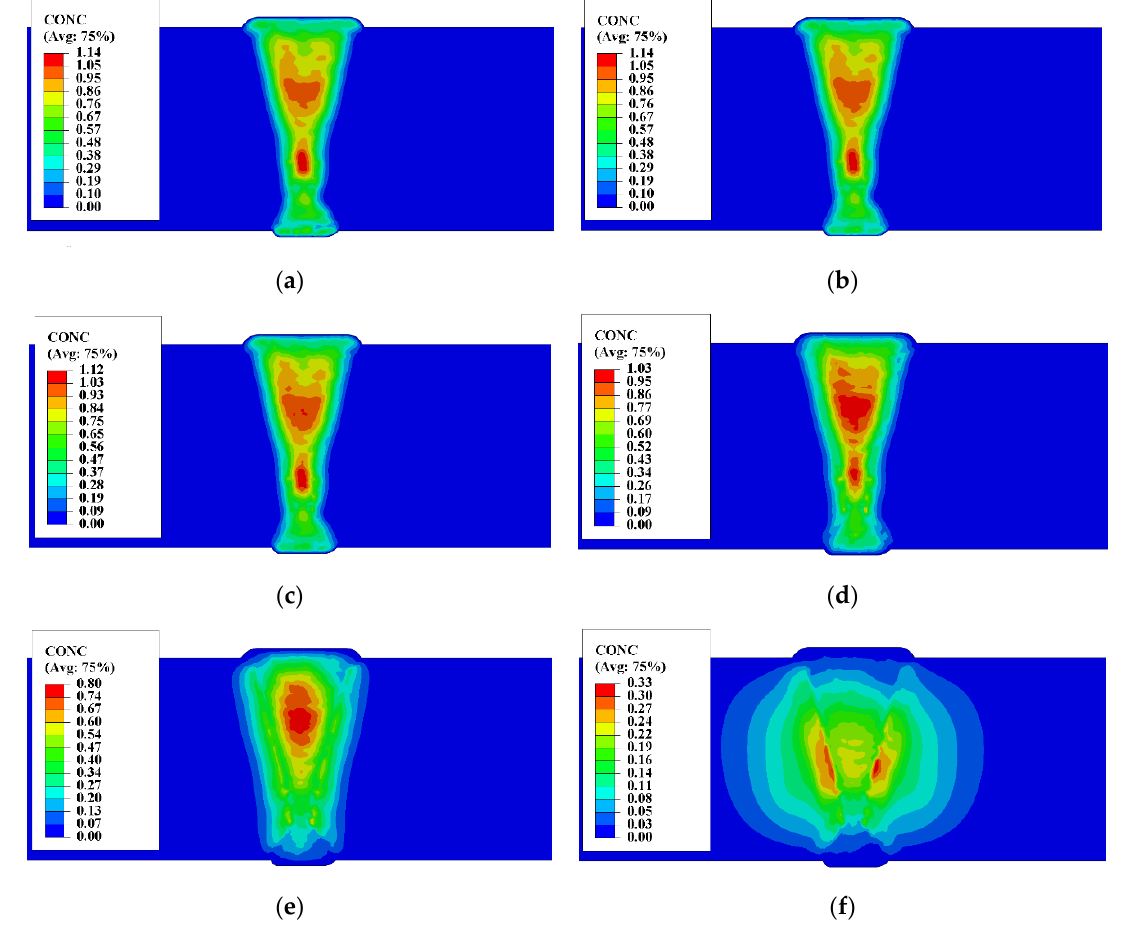
Figure 12. Distributing characteristics of hydrogen concentration (CONC) during cooling of heavy plate welding: ( a ) 1 h; ( b ) 10 h; ( c ) 100 h; ( d ) 1000 h; ( e ) 10,000 h; ( f ) 100,000 h.